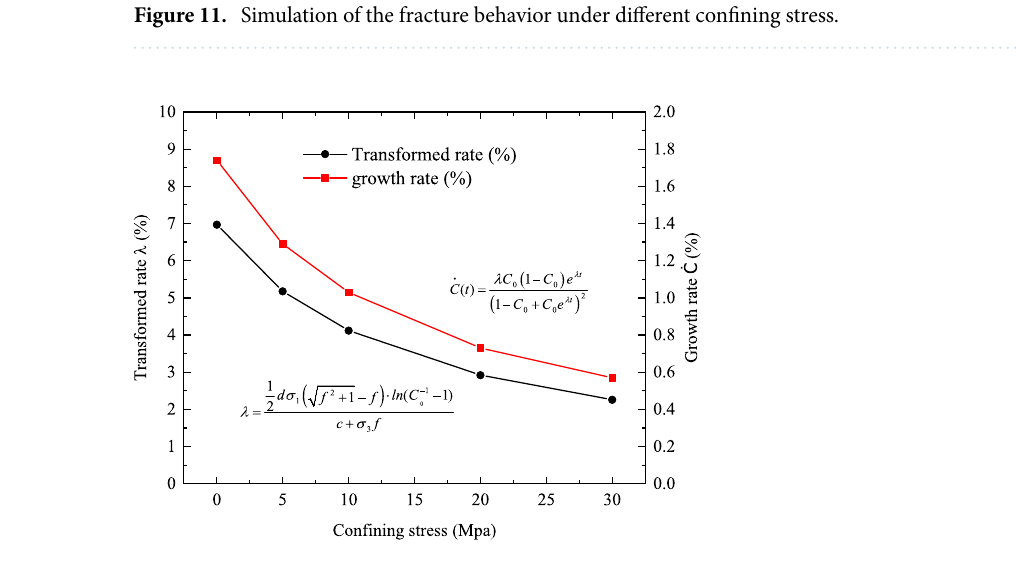
Figure 12. Transformation rate and growth rate over confining